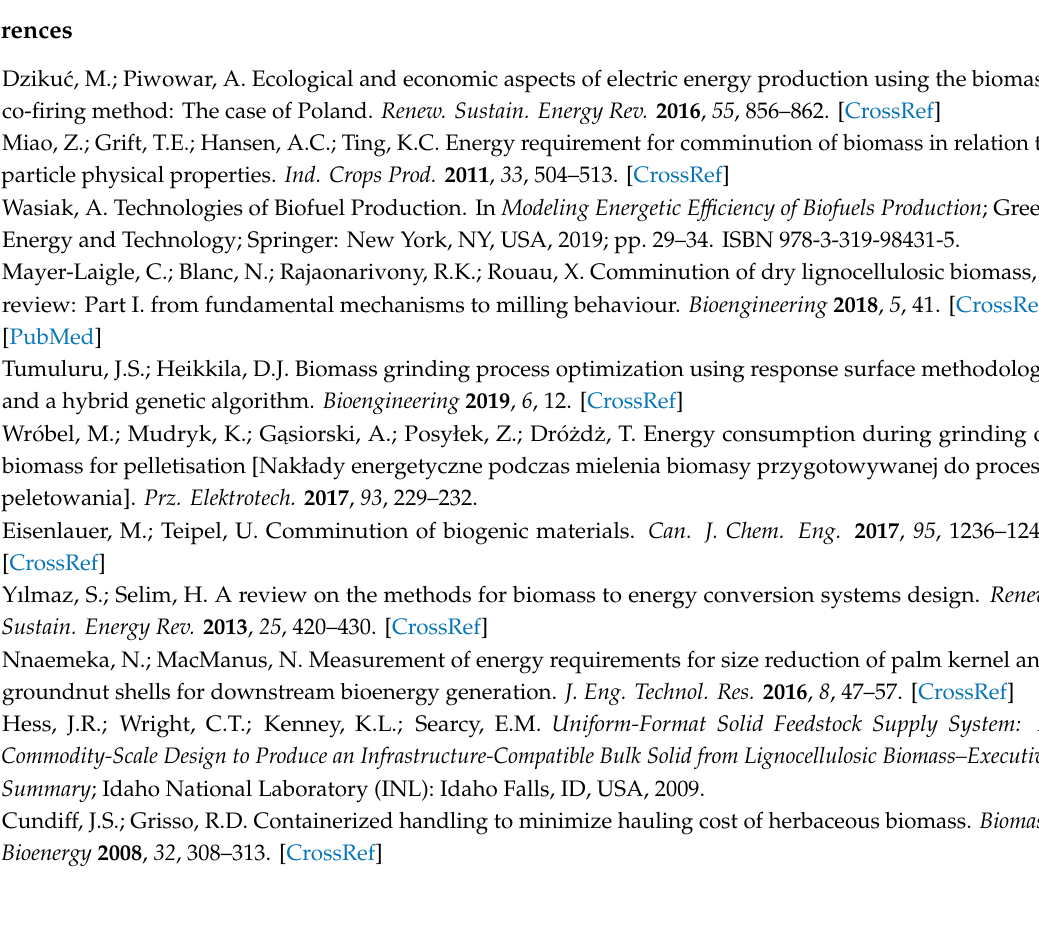
Table A8. Results of the analysis of variable correlation with the Spearman method for corn grinding. - - E j E zint Spearman Corr. 0.5963* − 0.51131* S ∆ ω p